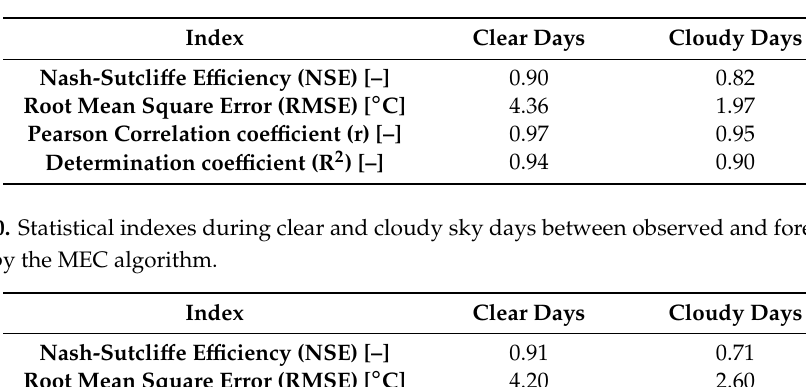
Table 9. Statistical indexes during clear and cloudy sky days between observed and simulated LST values by the MEC algorithm.